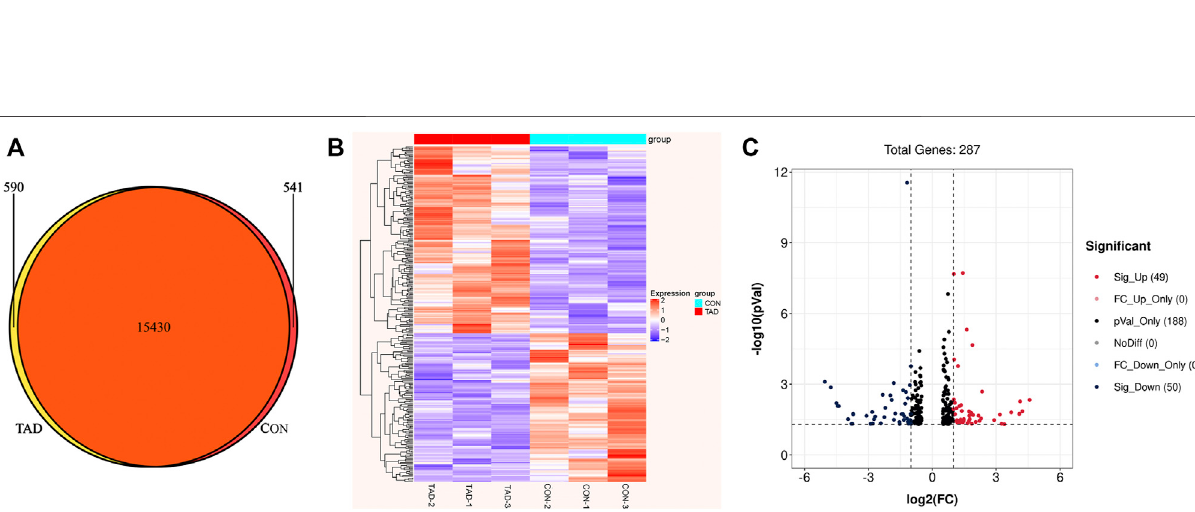
FIGURE1| Anti-tumoreffectoftadala fi lonhumancoloncancercelllines. (A) HCT116cells. (B) HT29cells. (C) SW620cells.Dataareexpressedasmean±SD, n = 5 (* p -value < 0.05, ** p -value < 0.01, and *** p -value < 0.001).